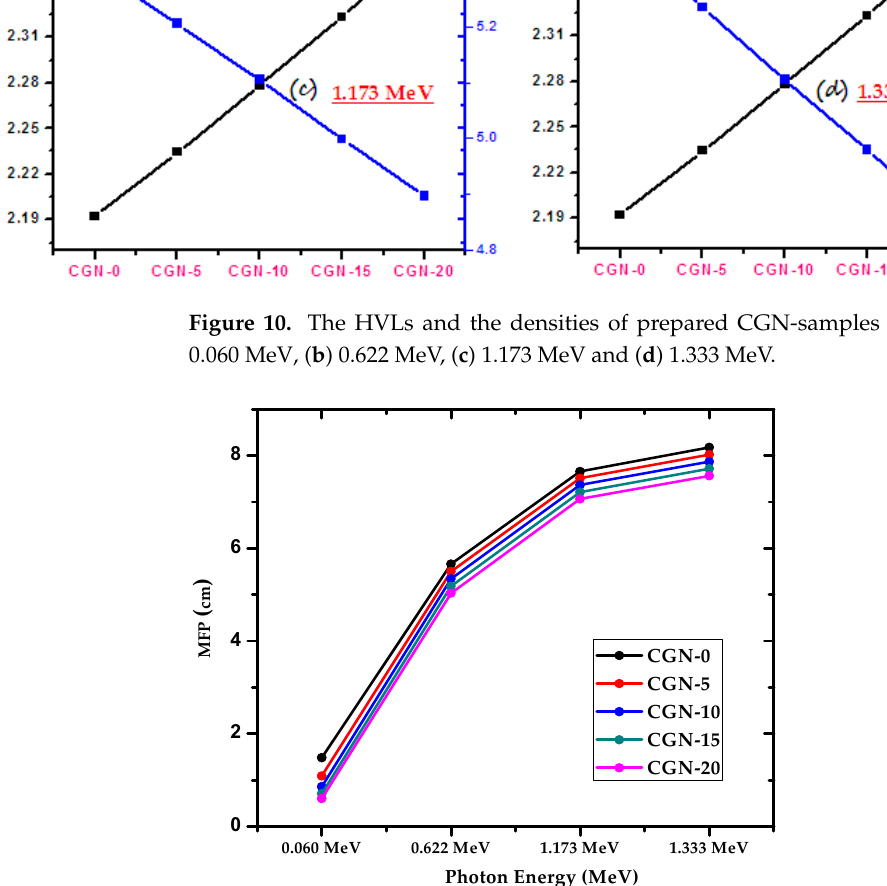
Figure 11. The MFP of prepared CGN-samples at different energies.